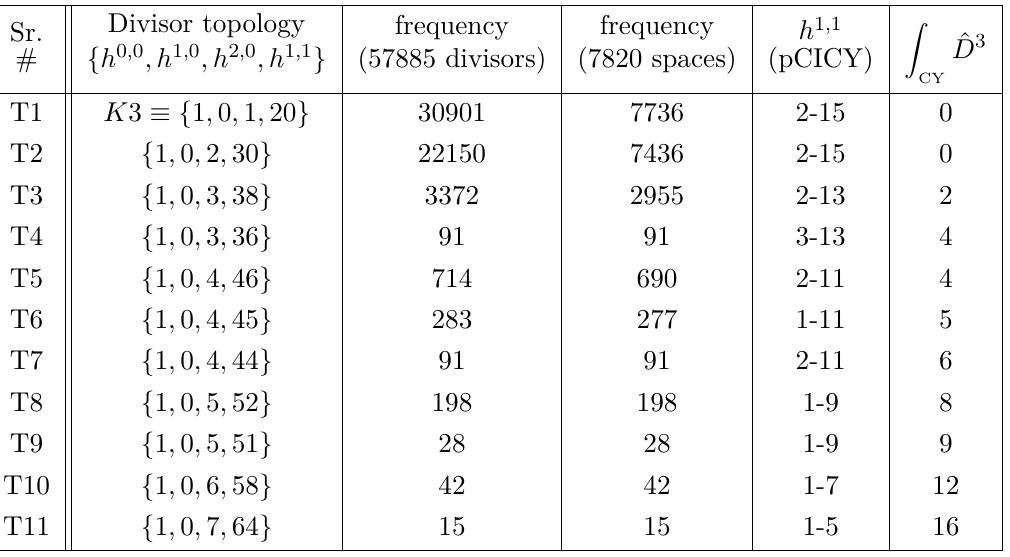
Table 2 . Divisor topologies for favorable pCICYs and their frequencies of